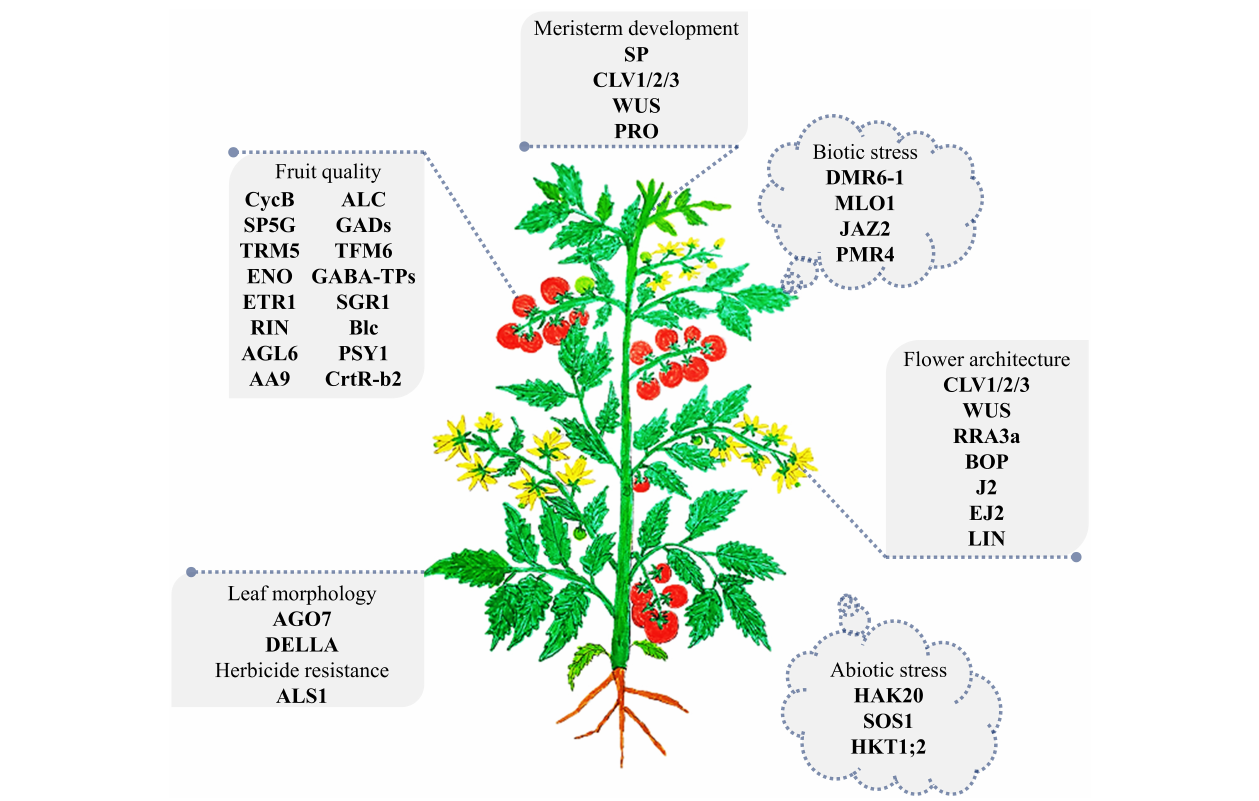
FIGURE 2 | The major genes targeted by CRISPR/Cas-based targeted mutagenesis in tomato. A representative tomato plant at the vegetative growth stage was drawn. The CRISPR/Cas edited genes are illustrated in association with the organs they affect. The abiotic stress gene set is shown surrounding the plant, indicating their global impacts on the plant. The detail of related studies is summarized in Table 1 . The plant is not drawn to